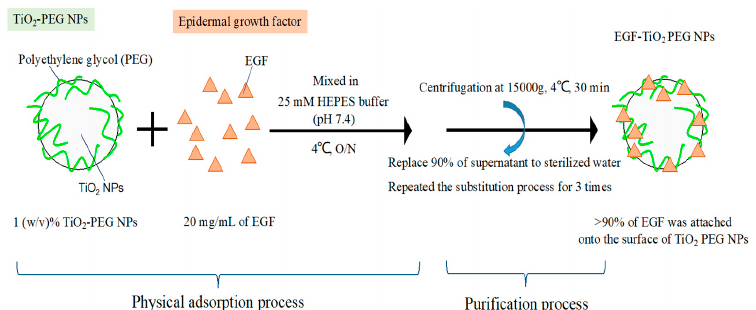
Figure 1. Construction of epidermal growth factor-ligated polyethylene glycol-coated titanium dioxide nanoparticles (EGF-TiO 2 PEG NPs). EGF was mixed with TiO 2 PEG NPs in a 20 mM HEPES buffer solution (pH 7.4) at 4 °C overnight. The mixture was centrifuged and reconstituted with free sterilized water. This substitution process was repeated three times, then EGF-conjugated TiO 2 PEG NPs were collected. The conjugation efficacy was more than 90% of the initial amount of EGF.